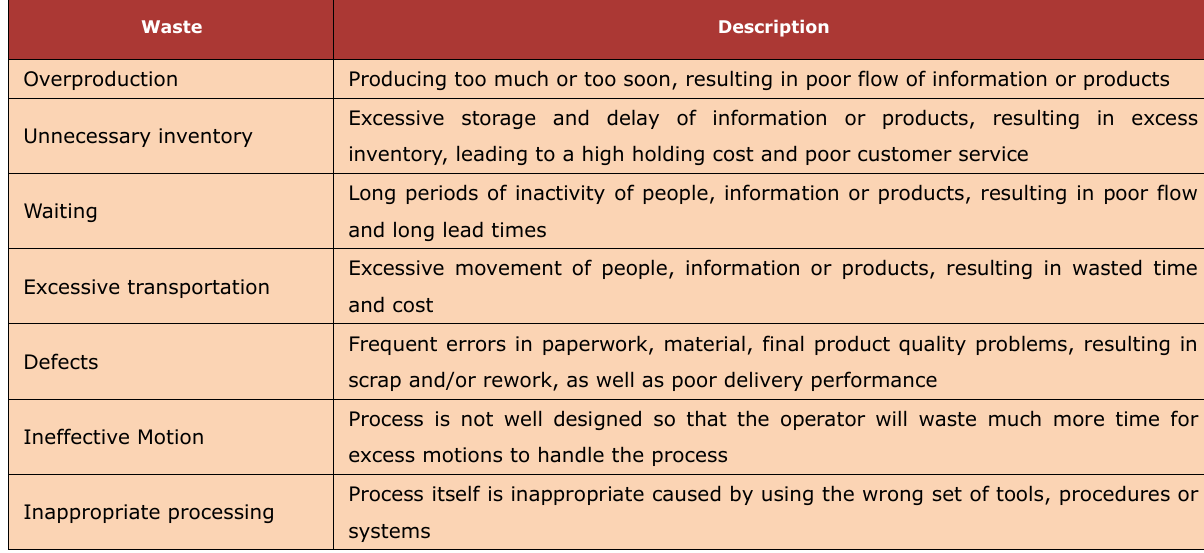
Table 1. Seven types of